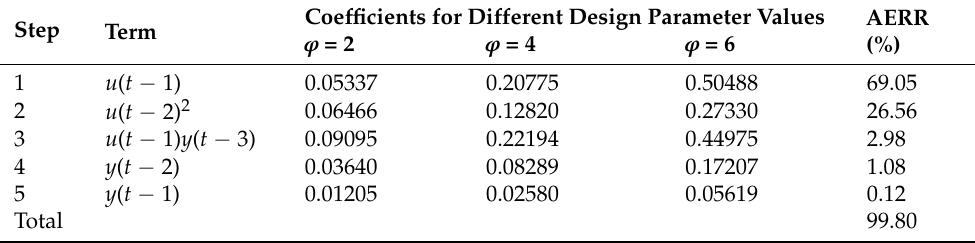
Table 1. The CMS identified by using the traditional EFOR algorithm. Step